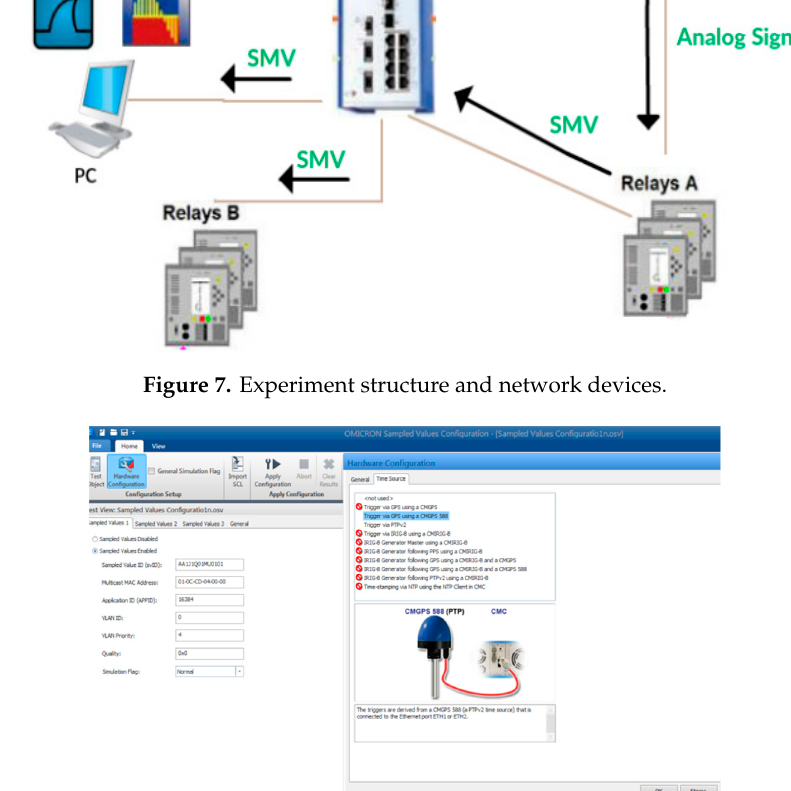
Figure 8. Omicron sampled measured values test configuration.